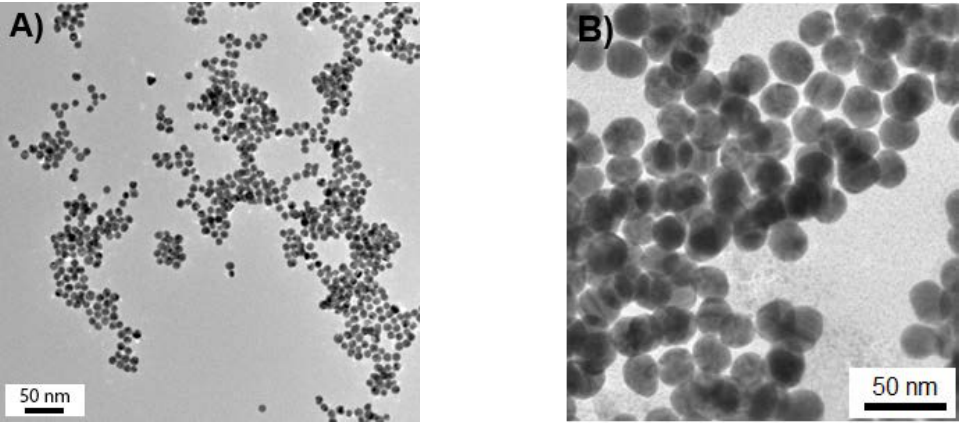
Figure 1. High-resolution transmission electron microscope (HRTEM) images of ( A ) sample 1 and ( B ) sample 4 of the prepared gold nanoparticles (GNPs). Table 1. Characteristics of gold nanoparticle (GNP) dispersions ( C Au0 = 3 mg /